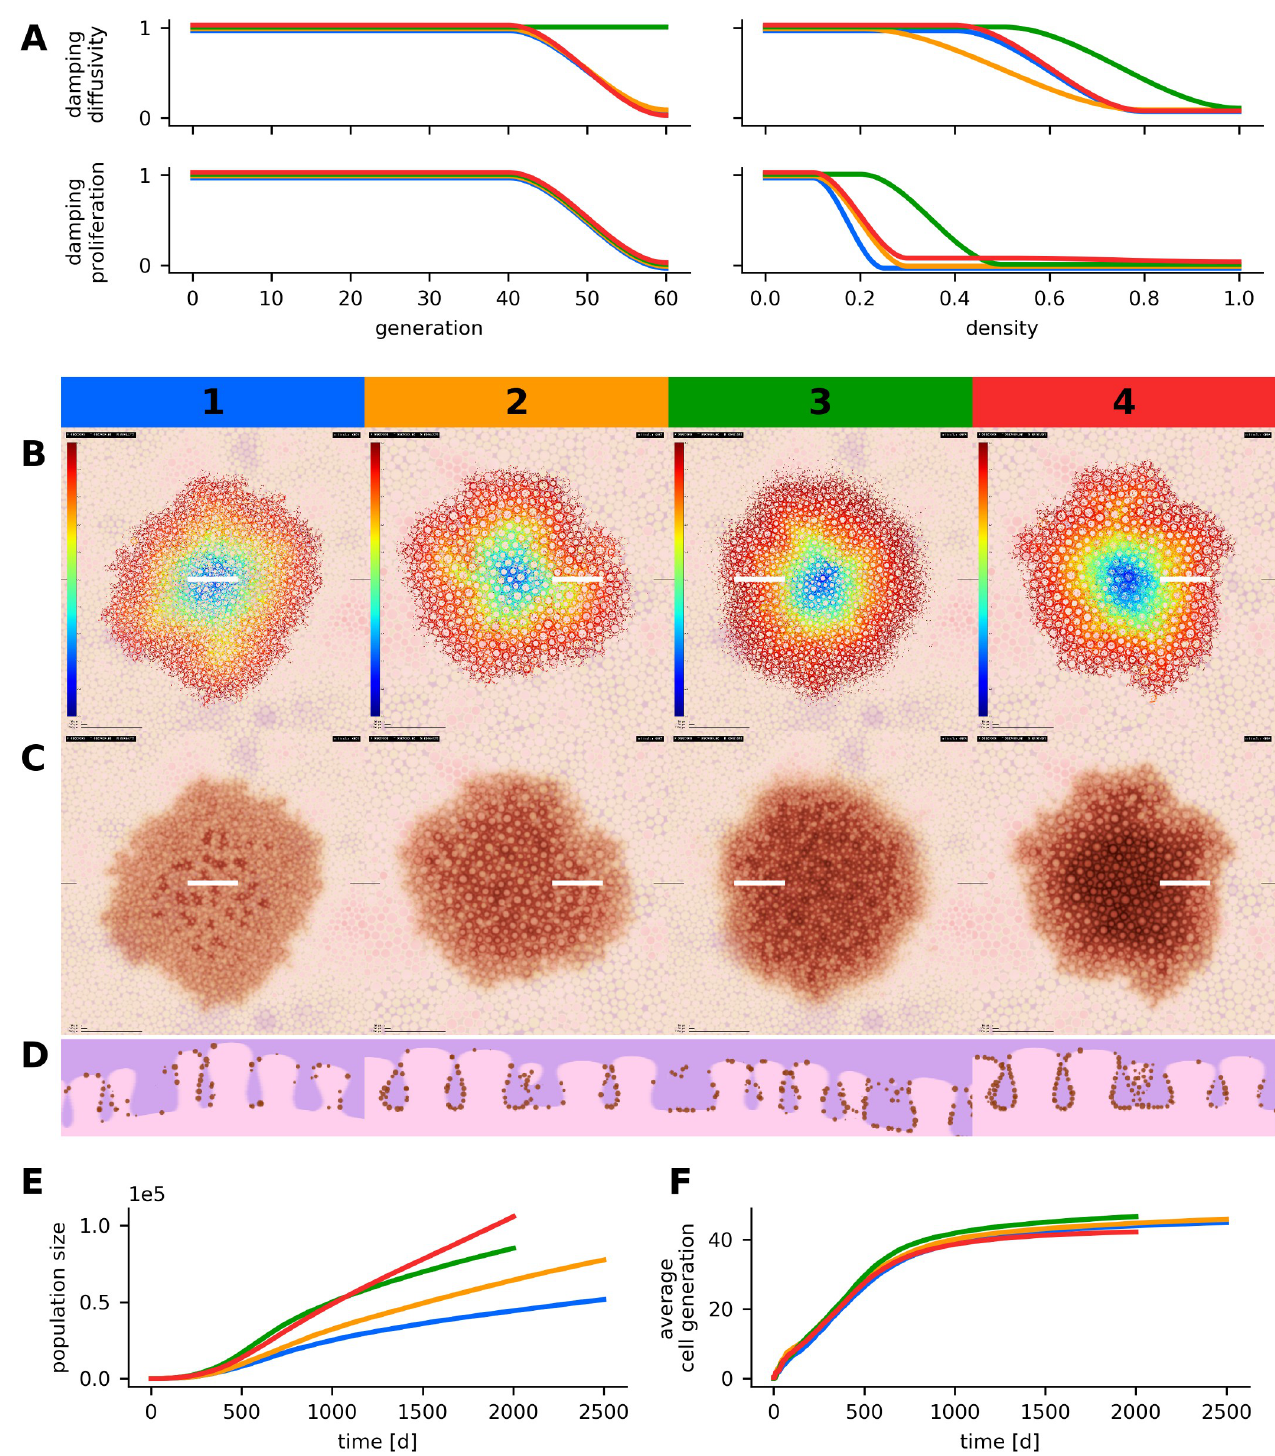
Fig 4. Parameter variation in simulated reticular nevi. The results of four simulations runs with different parameter configurations are compared. Each scenario corresponds to a number (1-4) and a specific color (blue, orange, green, red). (A) Configuration of generation and density dependent damping factors. For each of the four scenarios, four parameter curves are displayed in the respective colors. The parameter curves describe the damping factors for proliferation and diffusivity depending on generation number and local density. (B, C, D) Visualization of the spatial cell generation profiles (B)—the color map refers to generation numbers between 0 and 60—, simulated dermatoscopic views (C) and histologic views (D). All images depict the state of the simulated lesions after 2,000 or 2,500 days, horizontal images display a region of 5,000 μ m × 5,000 μ m and white markers indicate the location of the histologic section. (E) Temporal